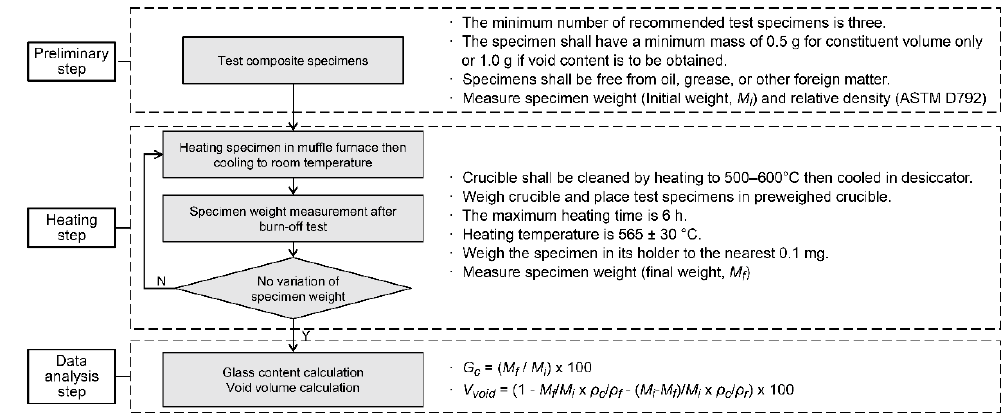
Figure 10. Burn-off test procedure for laminate structures, according to ASTM D792.